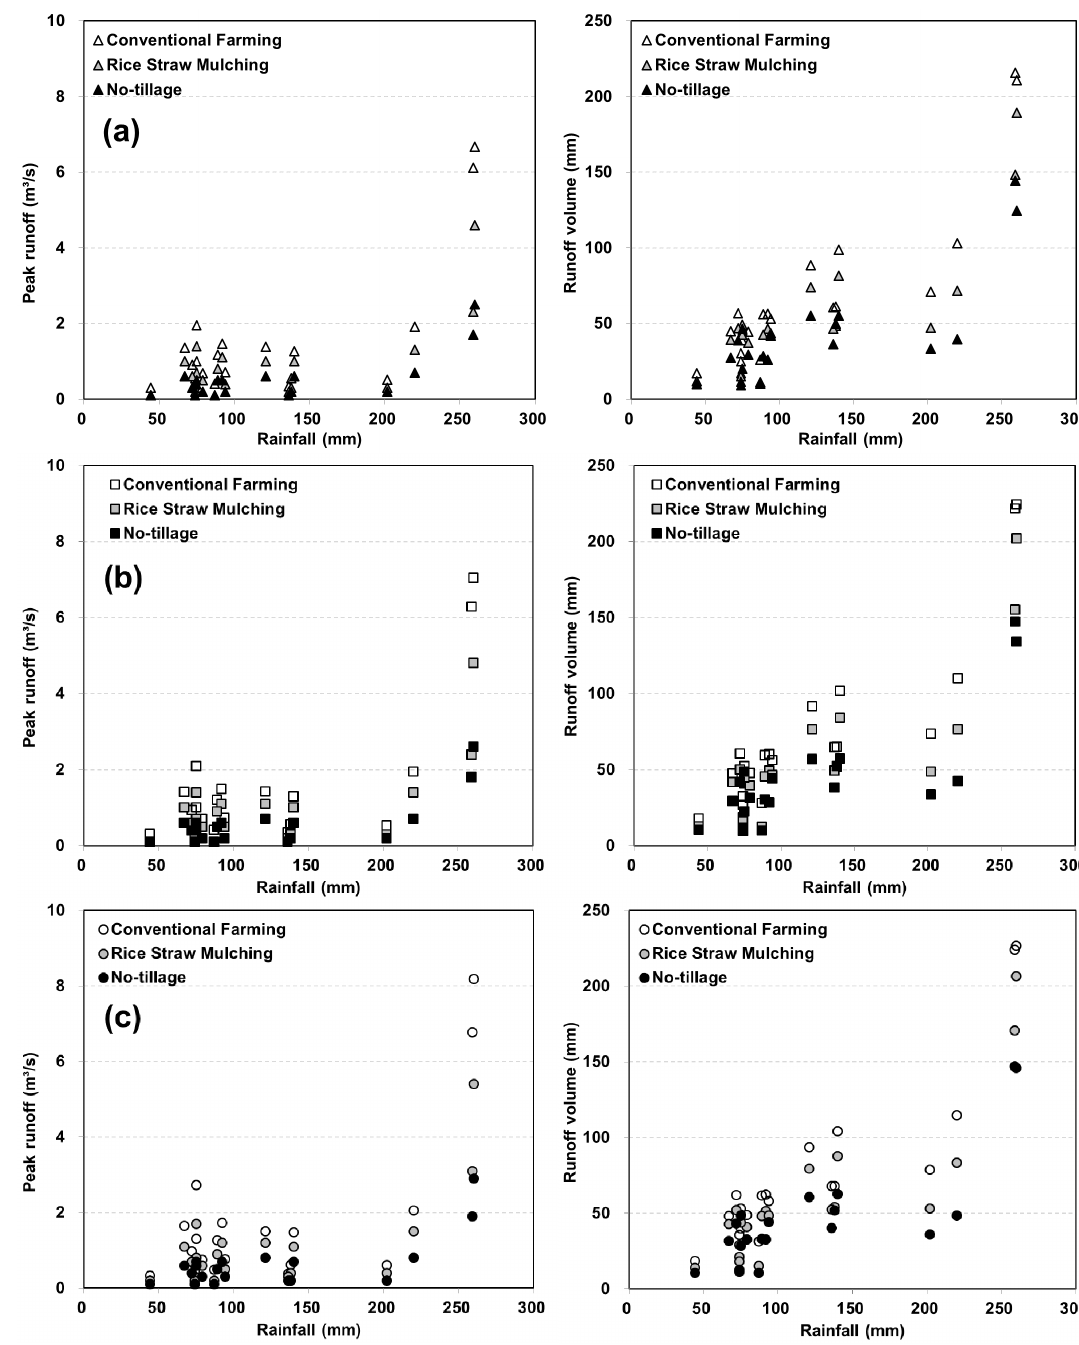
Figure 7. The peak runoff (left figure) and runoff volume (right figure) for rainfall events of the hourly simulated of the conventional, rice straw mulching and no-tillage operations for ( a ) baseline, ( b ) Scenario 1, and ( c ) Scenario 2 when applying change scenarios of upland crop areas